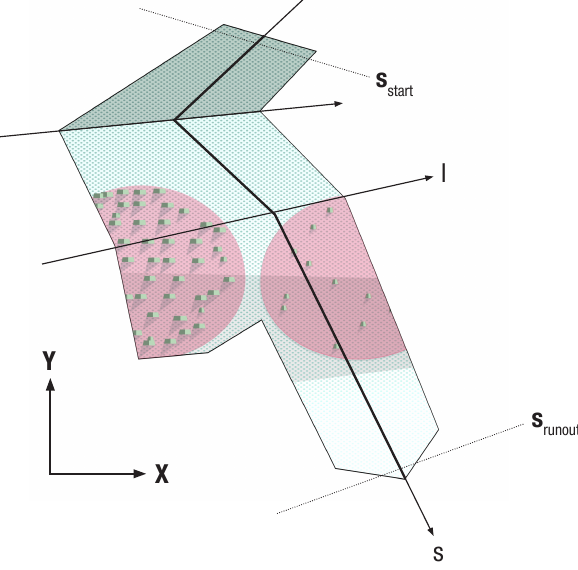
Figure 2. Schematic avalanche simulation result (see Fig. 1). Red areas correspond to forests with specific forest characteristics (i.e., tree density illustrated by green dots); displayed is the outline of the peak pressure field with a new coordinate system along the central flow line z(x, y) (in